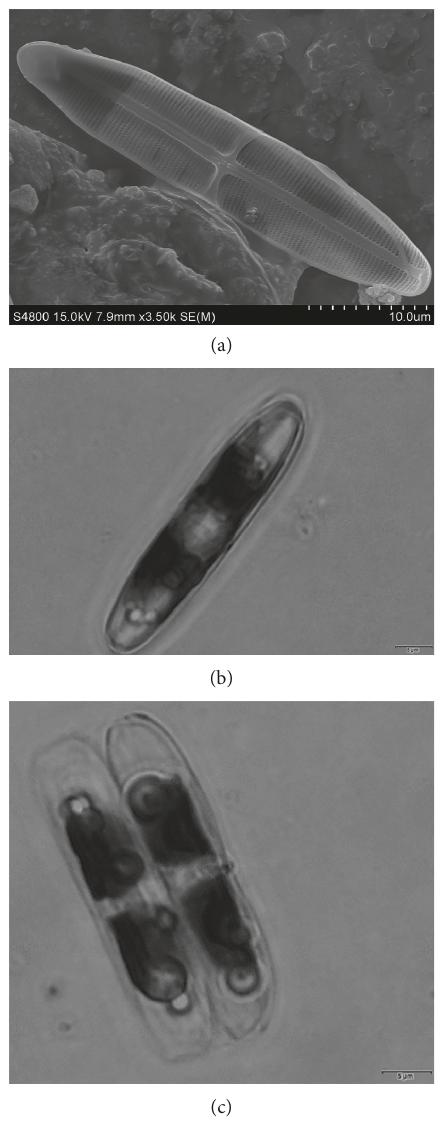
Figure 1: Scanning electron microscope (a) and optical microscope ((b) for valve view and (c) for girdle view) images of diatom Stauroneis